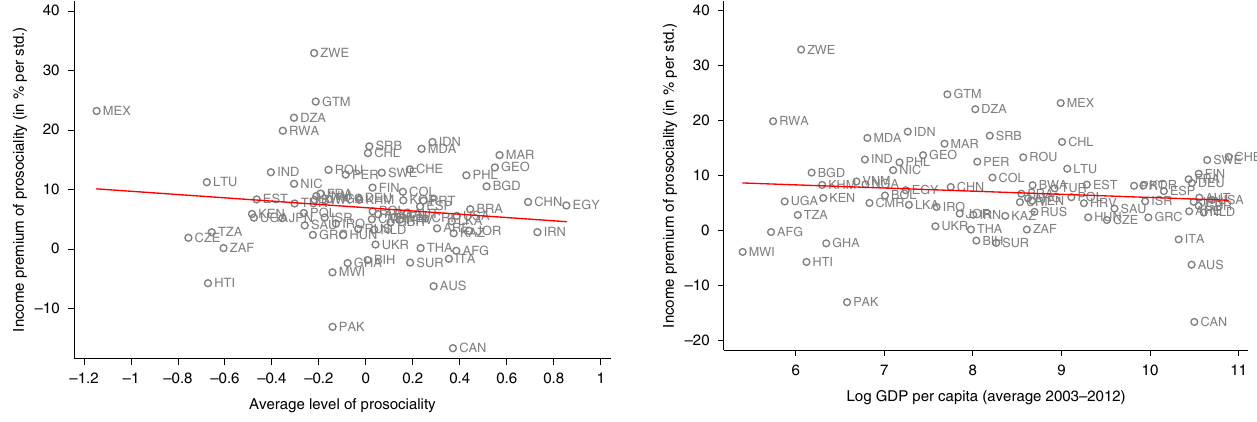
Fig. 2 The relationship between income premia of prosociality and the average level of prosociality. The red line indicates the prediction from a linear regression. The red line indicates the prediction from a linear regression. Spearman correlation: − 0.091 ( p = 0.436).